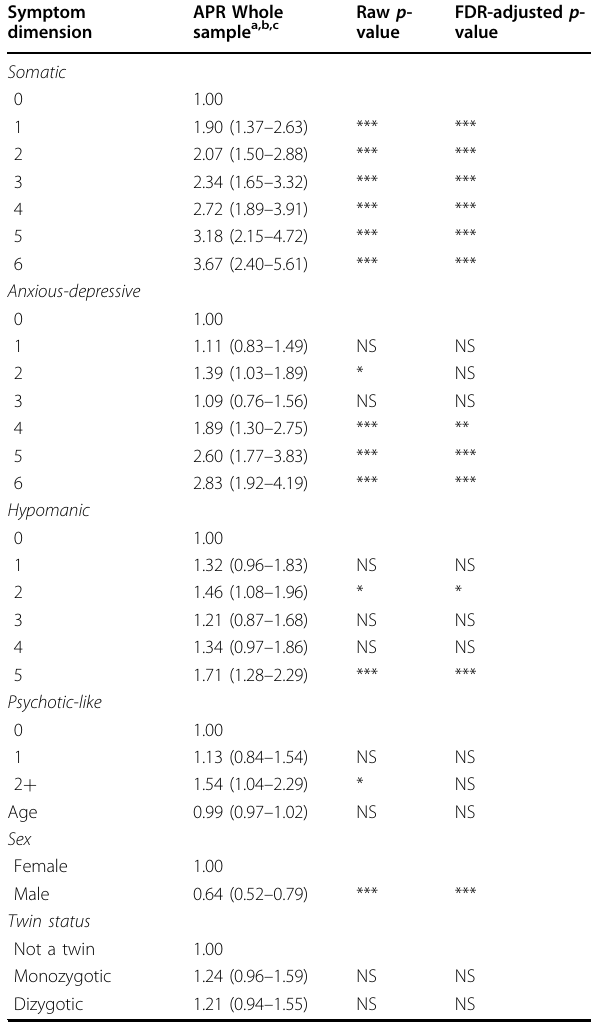
Table 2 Relationships between somatic, anxious- depressive hypo-manic, and psychotic-like, symptoms and “ days out of role ” in a community sample of young adults. Symptom APR Whole Raw p - dimension sample a,b,c